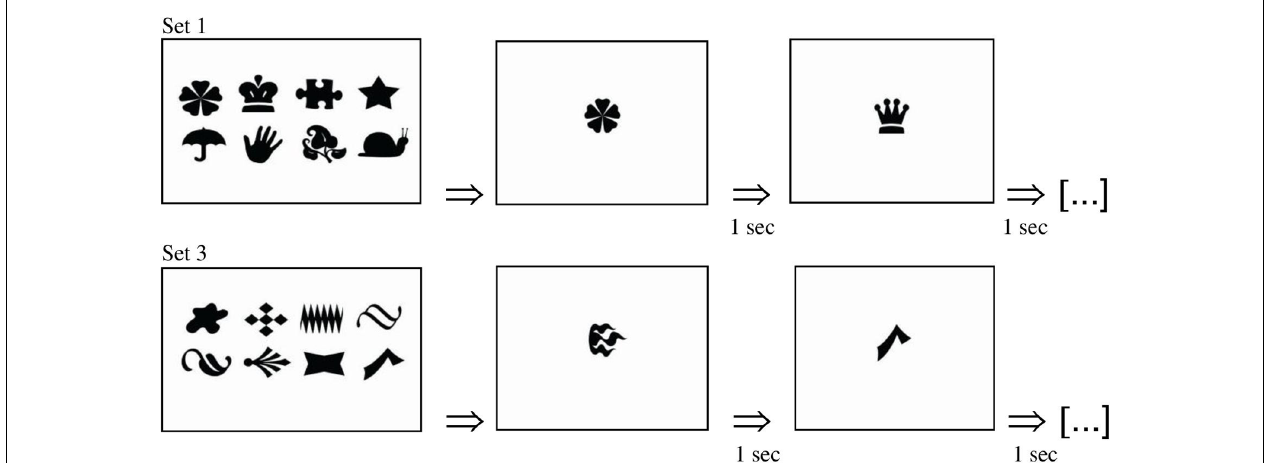
FIGURE 1 |Visual memory test’s schema. Four sets of stimuli (only two are presented here) were exhibited on the screen during 10 s and were followed by 24 figures, which were individually and randomly